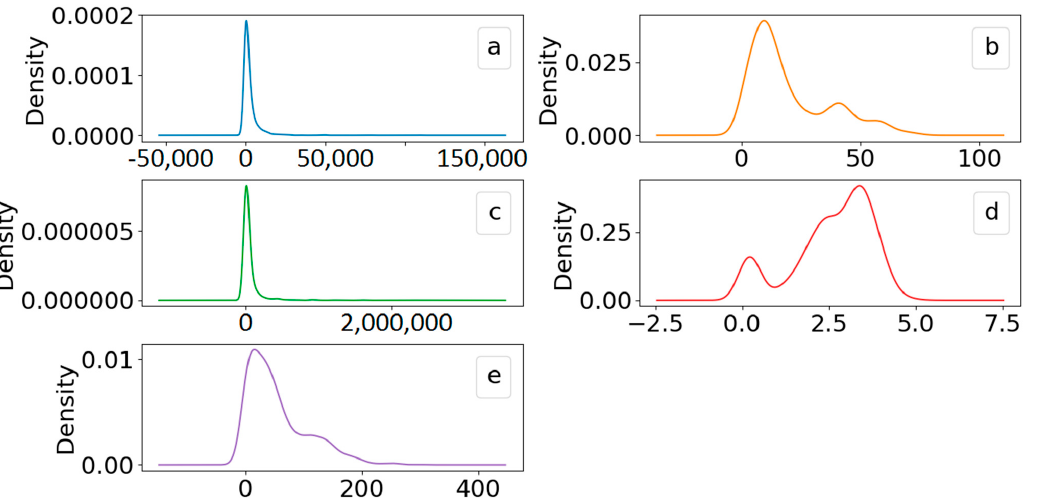
Figure 4. Density distribution of: ( a ) observed outage duration, ( b ) transformed outage duration, ( c ) total sales (USD millions) per minute, ( d ) total loss computed using transformed outage duration, and ( e ) total revenue loss computed using observed outage duration.